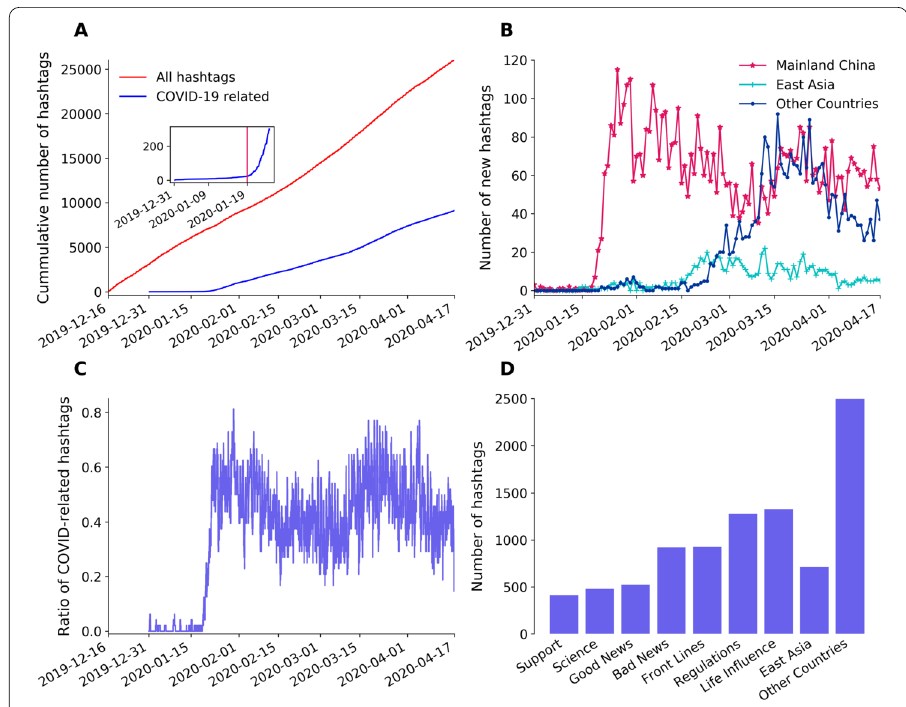
Figure 2 Overview of COVID-hashtags on Weibo re-ranked Hot Search List (HSL) throughout the pandemic. ( A ) Cumulative number of all hashtags and all COVID-hashtags with time. The inset indicates rapid increase in COVID-related hashtags starting from January 19 marked by a vertical red line. ( B ) Daily new COVID-hashtags on Mainland China, East Asia outside of Mainland China and Other Countries outside of East Asia. ( C ) Ratio of COVID-hashtags on the HSL at each timestamp. ( D ) Distribution of all COVID-hashtags by